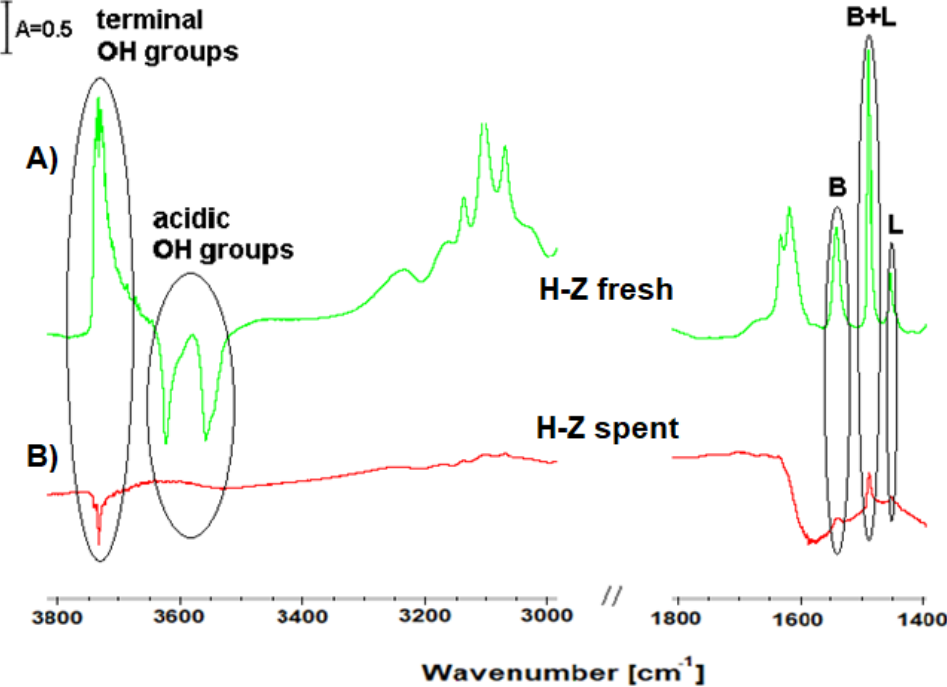
Figure A3. FT − IR spectra of the H-Z catalyst: ( A ) fresh sample, ( B ) spent sample (after reaction).